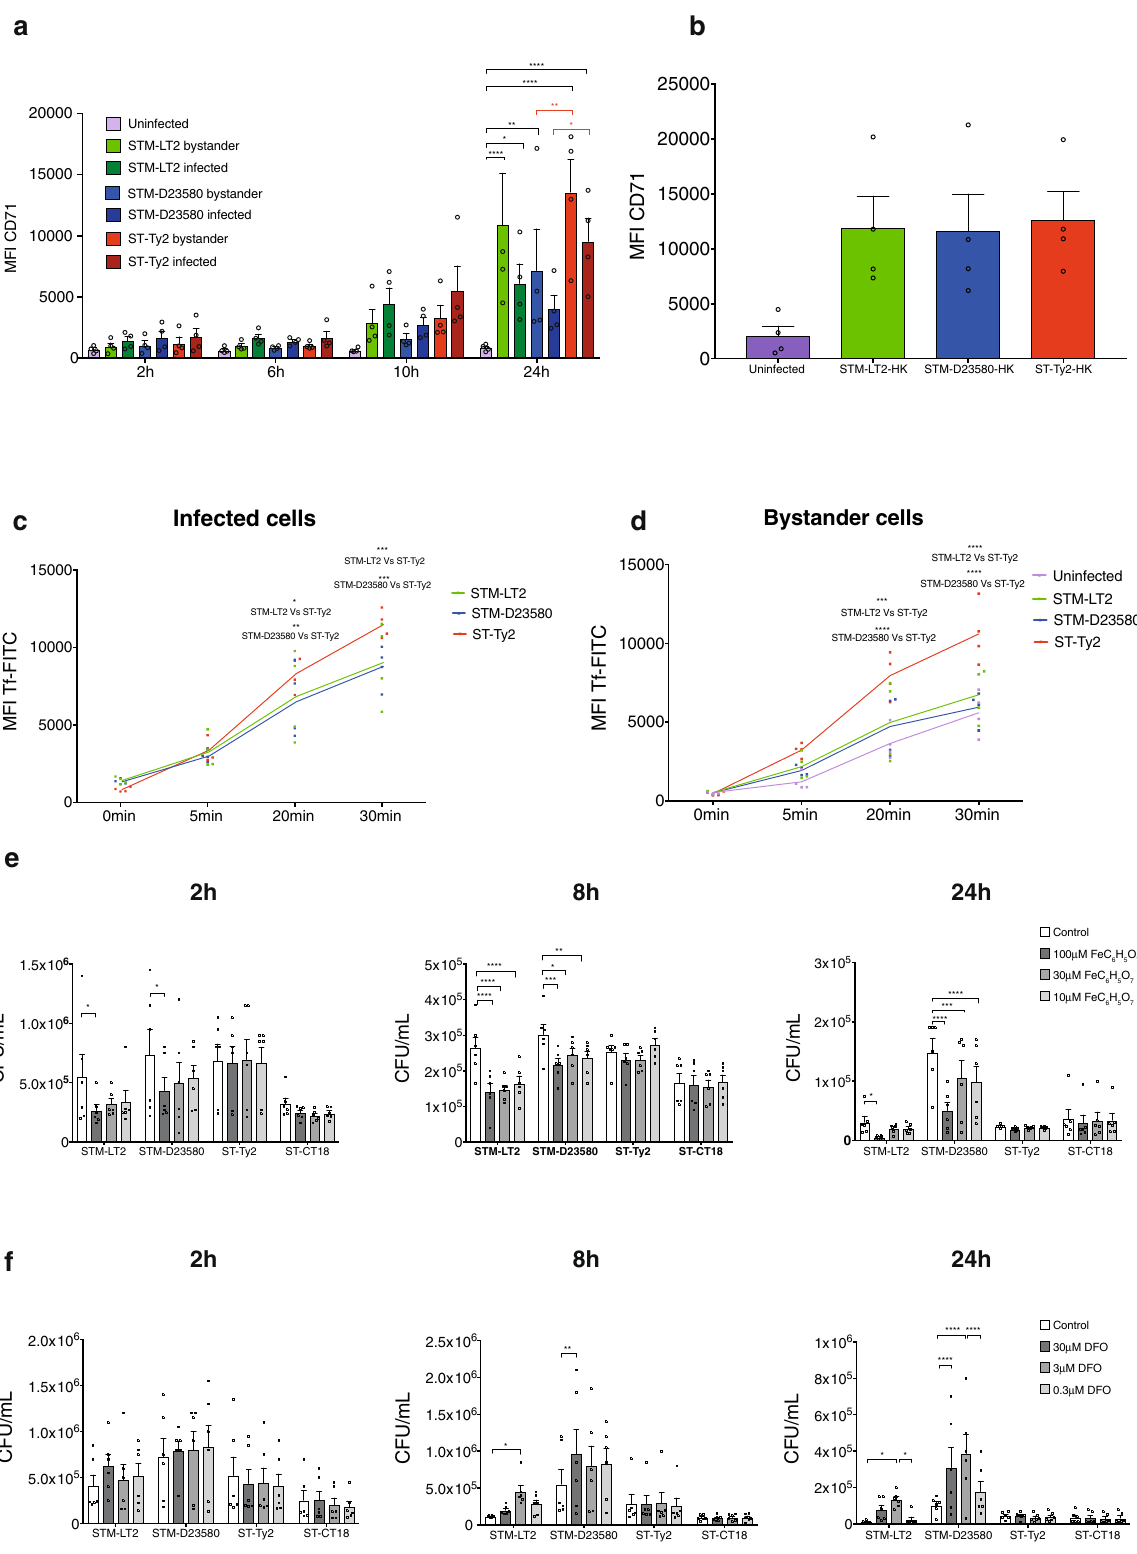
controlled 36 , however how dual-RNA seq suggested there may be strain-speci fi c differences in host oxidative stress responses (Fig. 3b and Supplementary Data 3 and 5). Iron plays an important role in oxidative and nitrosative stress, as an essential co-factor for the enzymes NADPH oxidase and NOS2, which produce ROI and RNI, respectively 37,38 . Free iron can